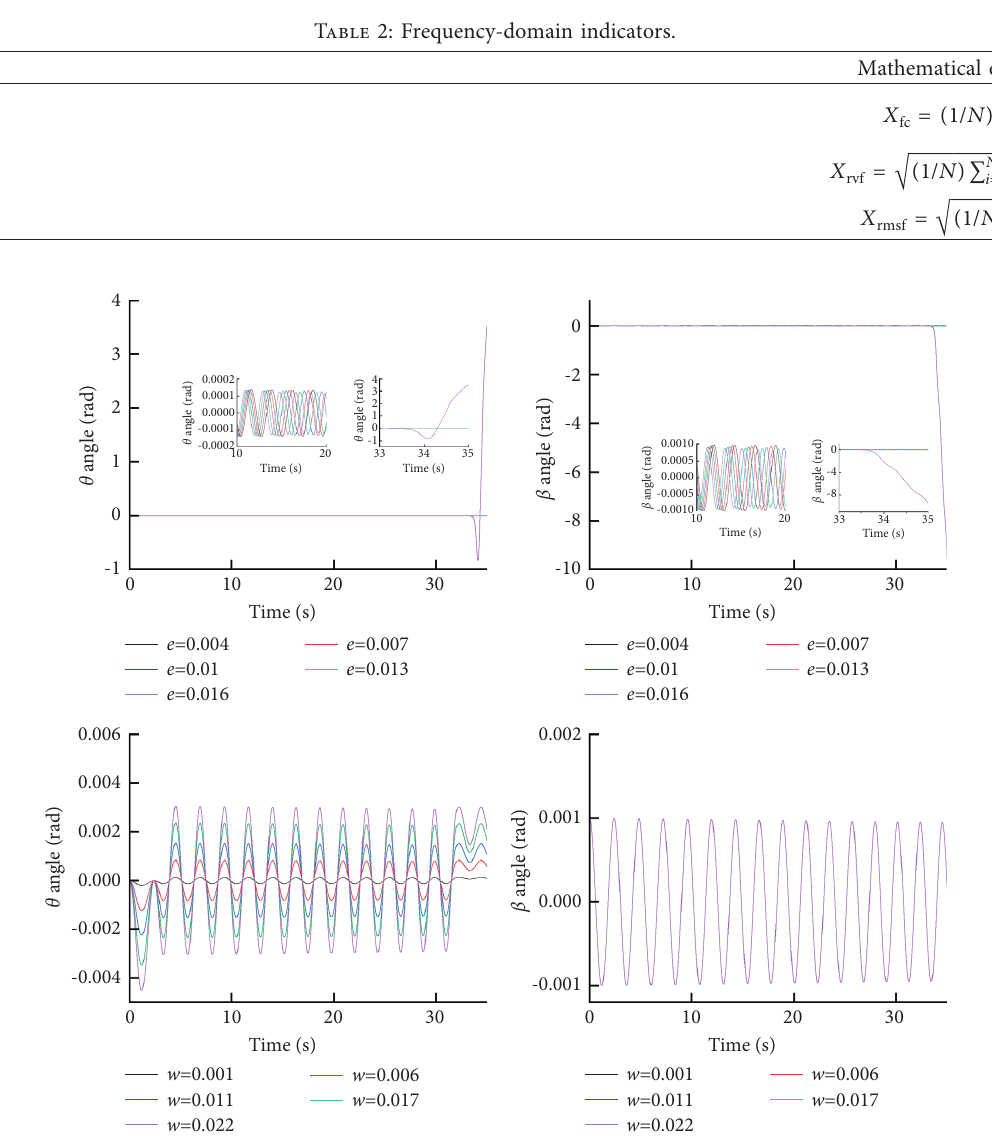
Table 2: Frequency-domain indicators.